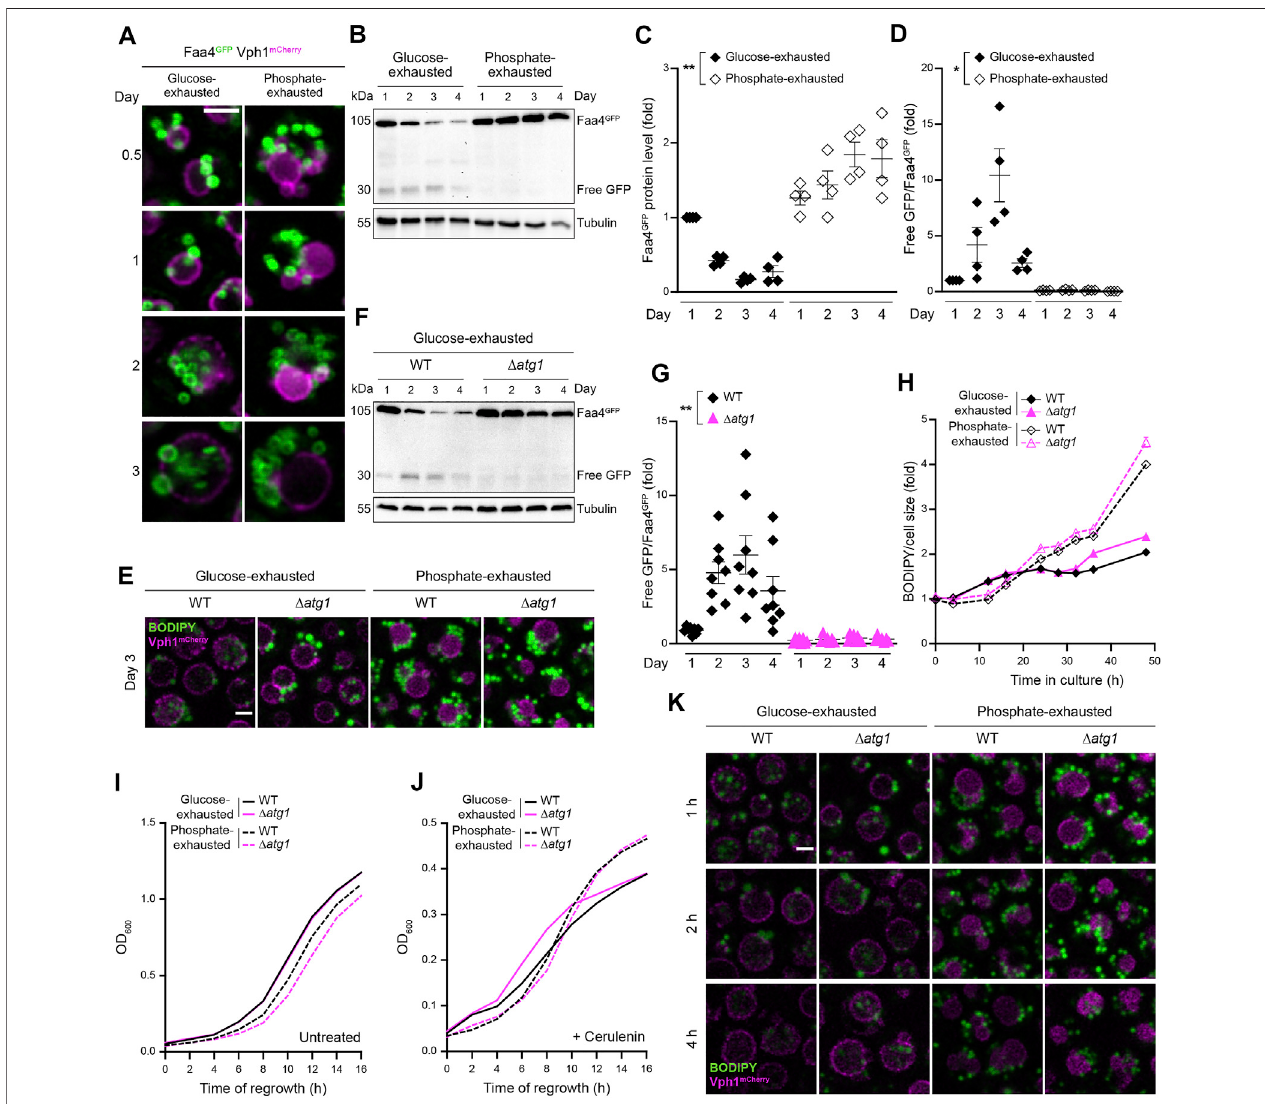
FIGURE5| Lipophagyisinducedbyglucosebutnotphosphateexhaustion (A) ConfocalmicrographsofWT(BY4742)cellsendogenouslyexpressingVph1 mCherry and Faa4 GFP to visualize vacuoles and LDs, respectively, at indicated time points. Scale bar: 2 μ m (B) Immunoblot analysis of protein extracts from WT cells endogenously expressingFaa4 GFP , subjected toglucoseorphosphateexhaustion for indicated time.BlotswereprobedwithantibodiesagainstGFPtodetectFaa4 GFP and freeGFP,and against tubulin as loading control (C,D) Densitometric quanti fi cation of immunoblots as depicted in (B). Faa4 GFP levels normalized to tubulin and standardized to glucose-exhaustion atday1(C) aswellastheratiooffreeGFPtoFaa4 GFP , indicating vacuolarturnover(D),are shown.Mean ±SEM; n = 4 (E) ConfocalmicrographsofWT and Δ atg1 cellsendogenouslyexpressingVph1 mCherry andstainedwithBODIPYafter3daysofglucoseorphosphateexhaustion.Scalebar:2 μ m (F,G) Immunoblotanalysis ofproteinextractsfromWTand Δ atg1 cellsexpressingFaa4 GFP subjectedtoglucoseexhaustionforindicatedtime(F)aswellascorrespondingdensitometricquanti fi cationof the ratio offree GFP toFaa4 GFP , indicating vacuolarturnover(G).Mean± SEM; n = 7 – 8 (H) Flow cytometric quanti fi cation ofLD biogenesisduring growth ofWT and Δ atg1 cellsintoglucoseorphosphateexhaustion.CellswerestainedwithBODIPYatindicatedtimepointsandvalueswerenormalizedtorespectivecellsize.Dataisshownasfold of glucose-exhausted WT cells upon inoculation. Mean ± SEM; n = 8 (I,J) Regrowth of WT and Δ atg1 cells after 3 days of glucose or phosphate exhaustion. Nutrient- exhausted cells were re-inoculated in unrestricted, fresh standard medium and OD 600 was monitored every 2 h. Cells were left untreated (I) or were treated with 1 µM cerulenin at the time point of re-inoculation (J) ; n = 6 (K) Confocal micrographs to visualize LD consumption during regrowth. After 3 days of nutrient exhaustion, WT and Δ atg1 cells expressing Vph1 mCherry were reinoculated, stained with BODIPY, immobilized on agar slides with unrestricted, fresh standard medium and were visualized at indicated time points. Scale bar: 2 μ m. For more details in respect to statistical analyses, please see Supplementary Table S4 .